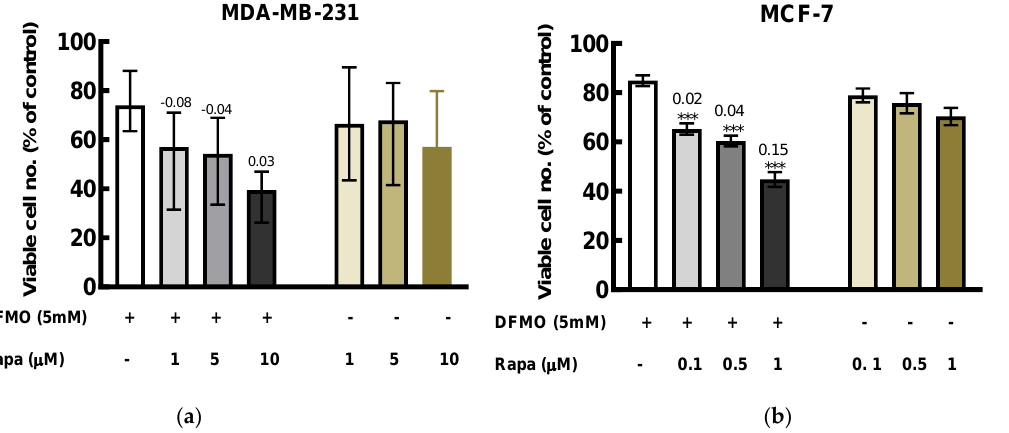
Figure 5. Effect of DFMO and rapamycin on viability of breast cancer cells . Cells were treated with DFMO and ra- pamycin, singularly and in combination at the indicated concentrations for 48 h, cytotoxicity was measured using MTT assay. ( a ) MDA-MB-231 cells in the presence of DFMO and rapamycin. ( b ) MCF-7 cells in the presence of DFMO and rapamycin (because MCF-7 cell was more sensitive to rapamycin treatment, lower concentrations was used). The results were expressed as the percentage of viable cells compared to the untreated control. Values shown are mean ± S.E.M, of at least 18 wells from three independent experiments for MCF-7 and mean ± range, of at least 12 wells from two inde- pendent experiments for MDA-MB-231. Note : Rapa represents rapamycin. Statistics was performed using one-way ANOVA with Dunnett’s post hoc analysis, where *** p < 0.001 vs. DFMO alone. The values above the bars for the combination treatment are the EOB scores.